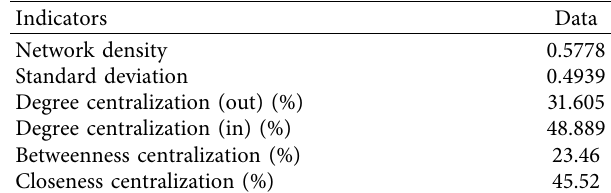
Table 3: Indicators of trust network structure in the competitive bidding